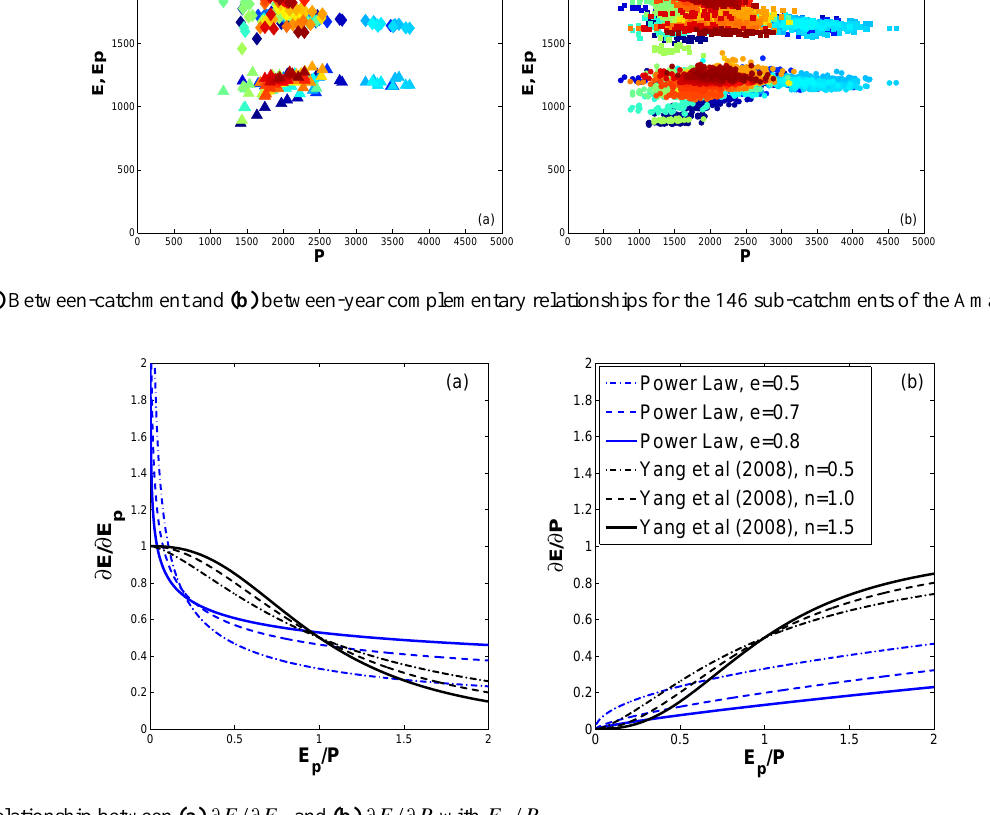
Figure 8. Relationship between (a) ∂E/∂E p and (b) ∂E/∂P with E p /P